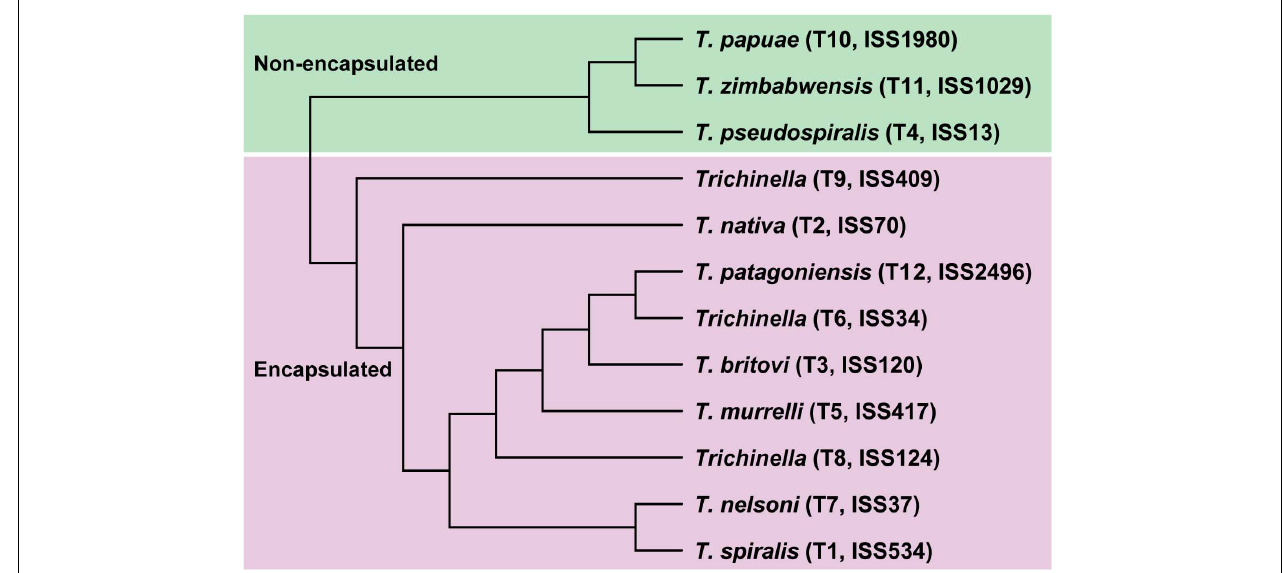
FIGURE 1 | Phylogenetic analysis of the 12 Trichinella species based on common SNVs.